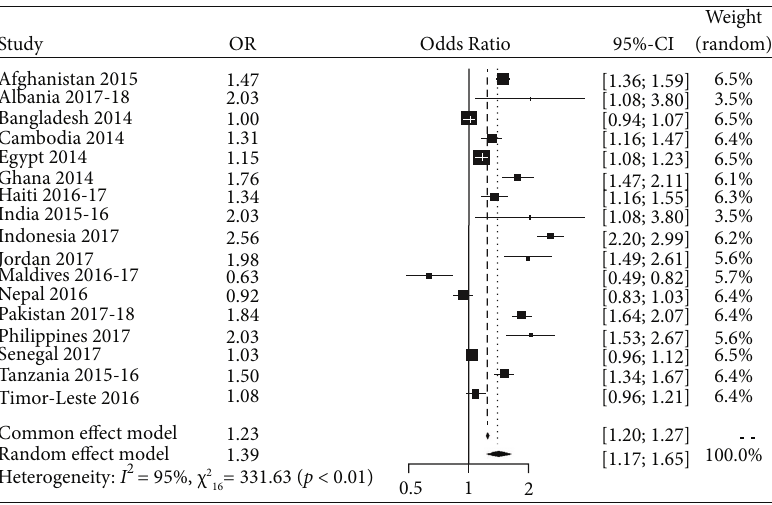
Figure 2: Forest plot for the variable respondent